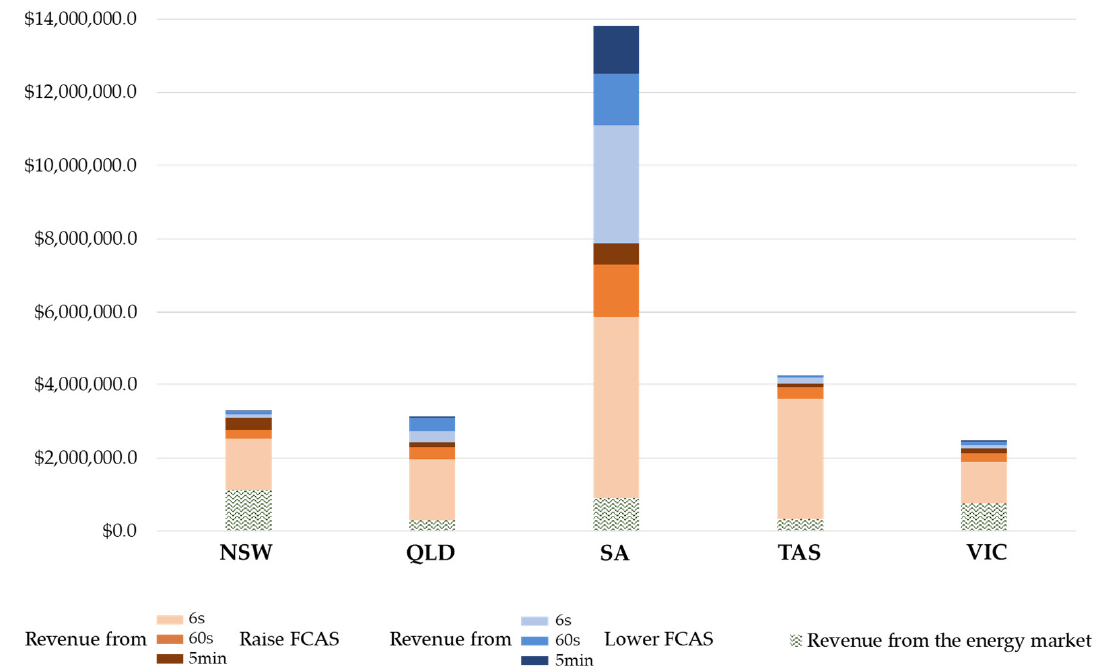
Figure 14. One-year operation of the battery in regional markets of